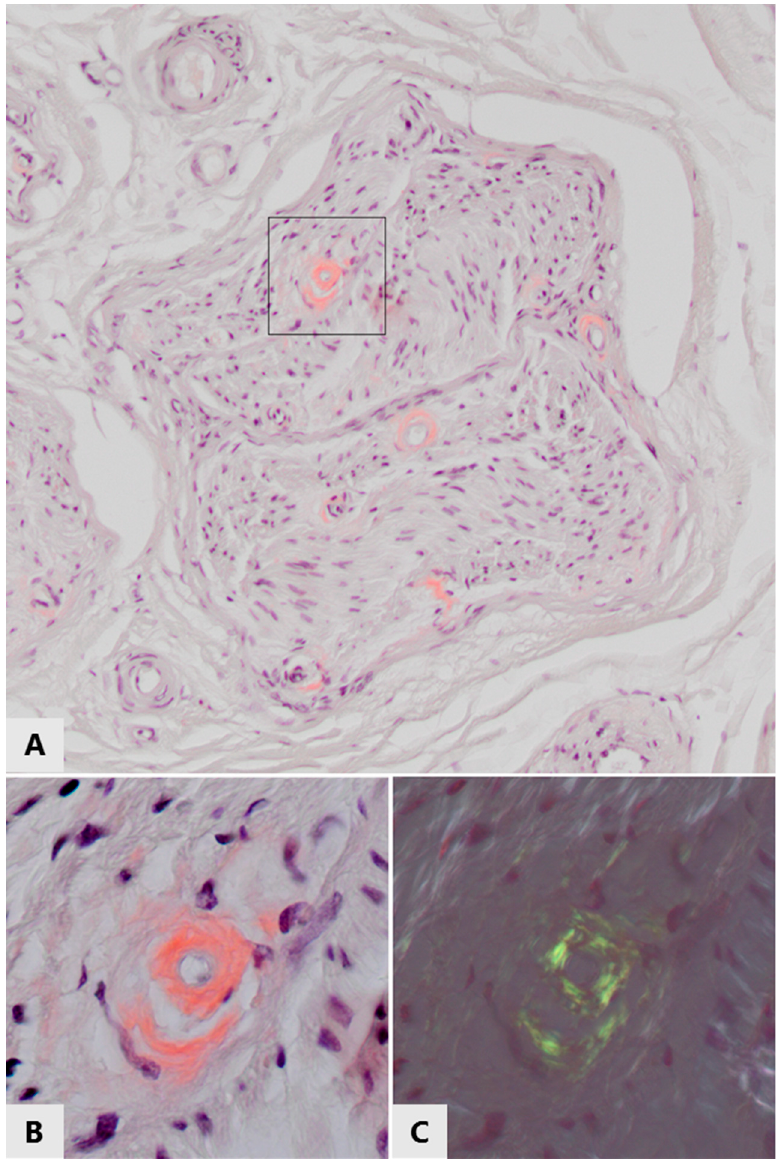
Figure 3. Amyloid deposits in / around small endoneurial blood vessels in the left sural nerve of a 70-year old patient with immunoglobulin light chain amyloidosis. ( A ) White light microscopy of Congo red stained section, showing pink-stained thickening of vascular walls in a nerve fasciculus. These thickened vascular walls also stained positive for lambda light chains (not shown). ( B , C ) Enlargement of the framed area of the top panel, ( B ) viewed with white light, ( C ) viewed with polarized light, showing green / yellow birefringence of the Congo red positive vascular walls, proving the amyloid nature of these light chain deposits.